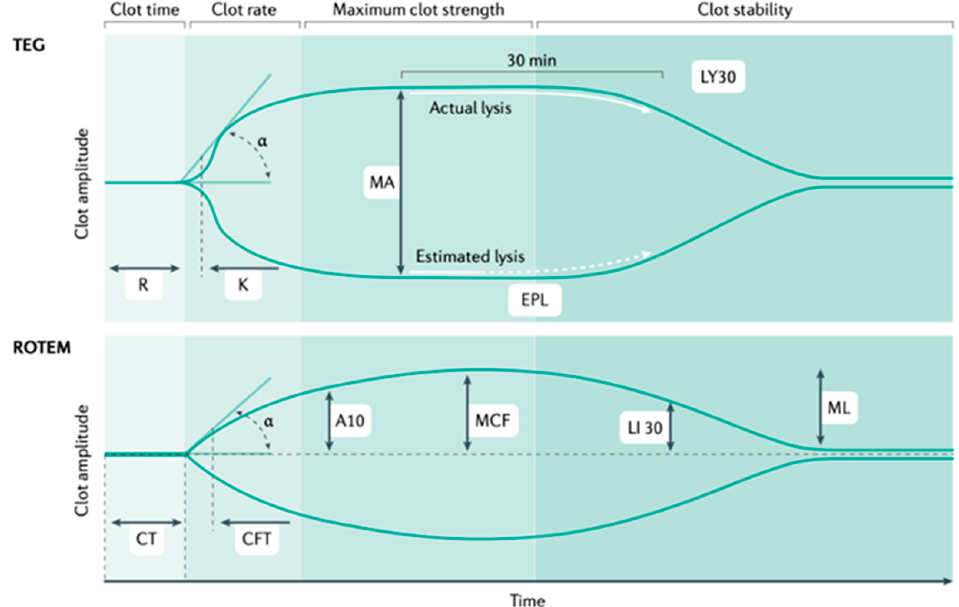
Figure 4. TEG (thromboelastography) and ROTEM (rotational thromboelastometry). TEG and ROTEM measure the speed of thrombin generation as measured by clot fi rmness of 2 mm (reaction time (R) in TEG and clo tt ing time (CT) in ROTEM); the speed of clot formation, which includes the contribution of fi brinogen ( α angle in both assays); the maximum clot strength (maximal amplitude (MA) in TEG and maximal clot fi rmness (MCF) in ROTEM); and the magnitude of fi brinolysis (LY30; that is, the percentage reduc- tion in the area under the curve at 30 min after MA in TEG, and LY30, the residual clot fi rmness at 30 min after CT in ROTEM) (see Figure 4) [20]. TEG stands for thromboelas-